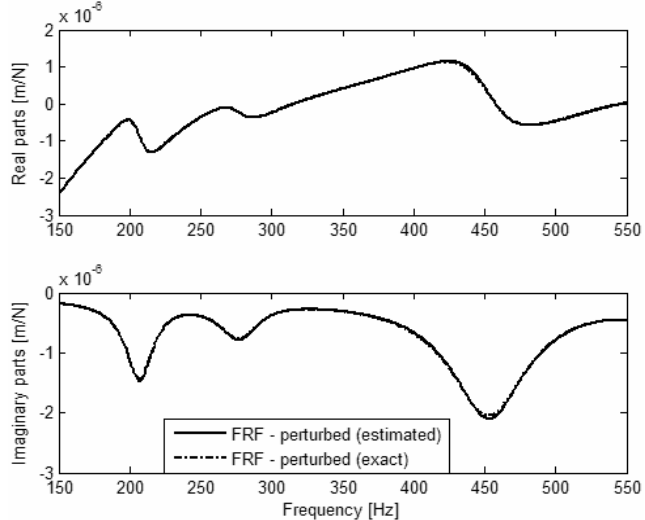
Fig. 9. Exact and first-order estimation of the FRF H II ( ω,T,p ) of the perturbed system by variations of the viscoelastic layer thickness.